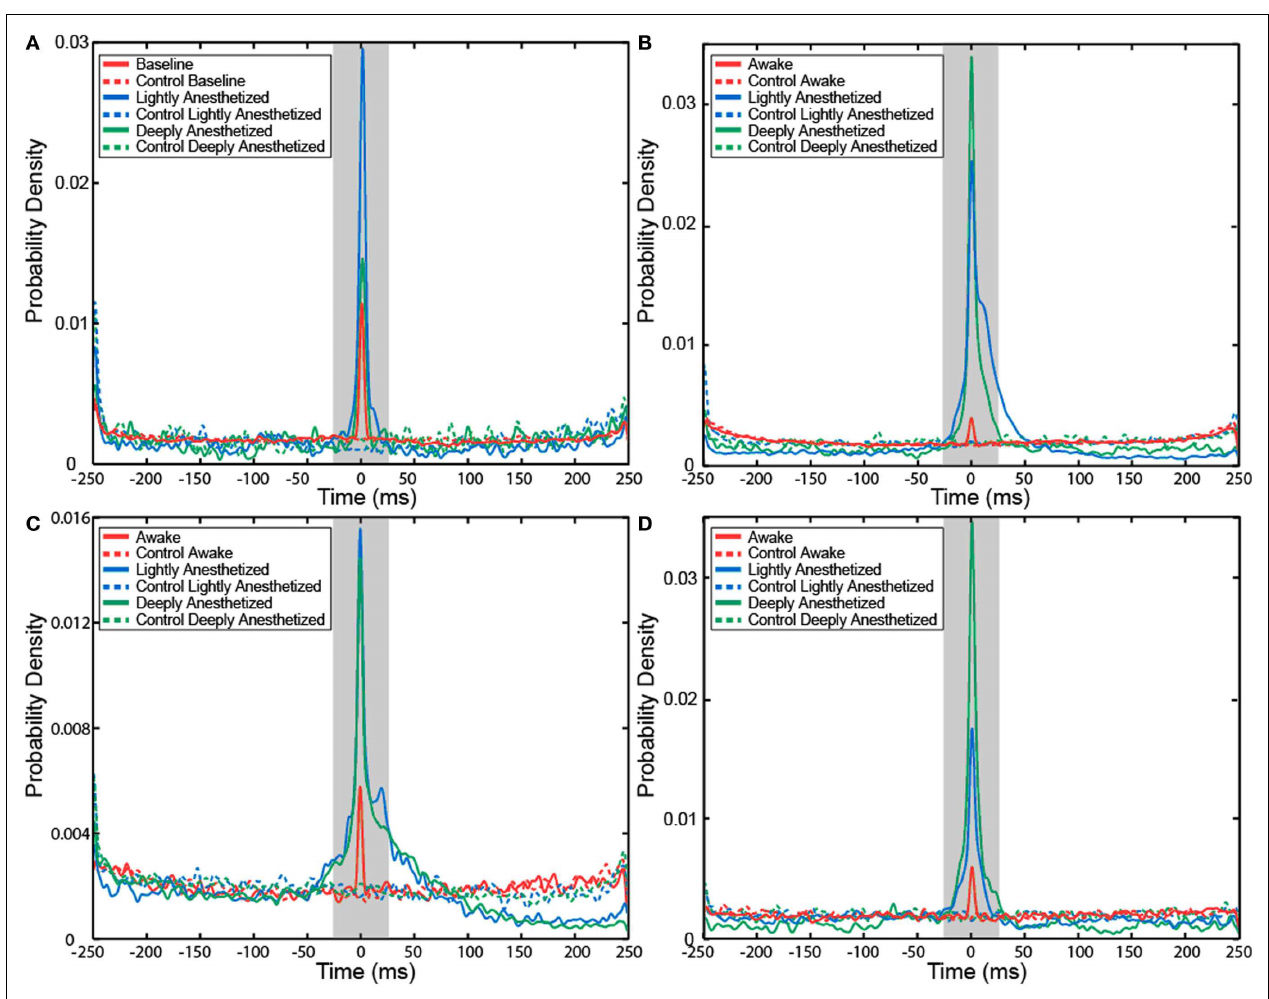
consistent temporal relationship.With propofol administration, the probability of an AP occurring at the local minimum of the LFP increased. Dashed lines represent the control cases in which randomly generated AP times were used to align the LFP. Red represents the awake or baseline state. Blue represents the lightly anesthetized state. Green represents the deeply anesthetized